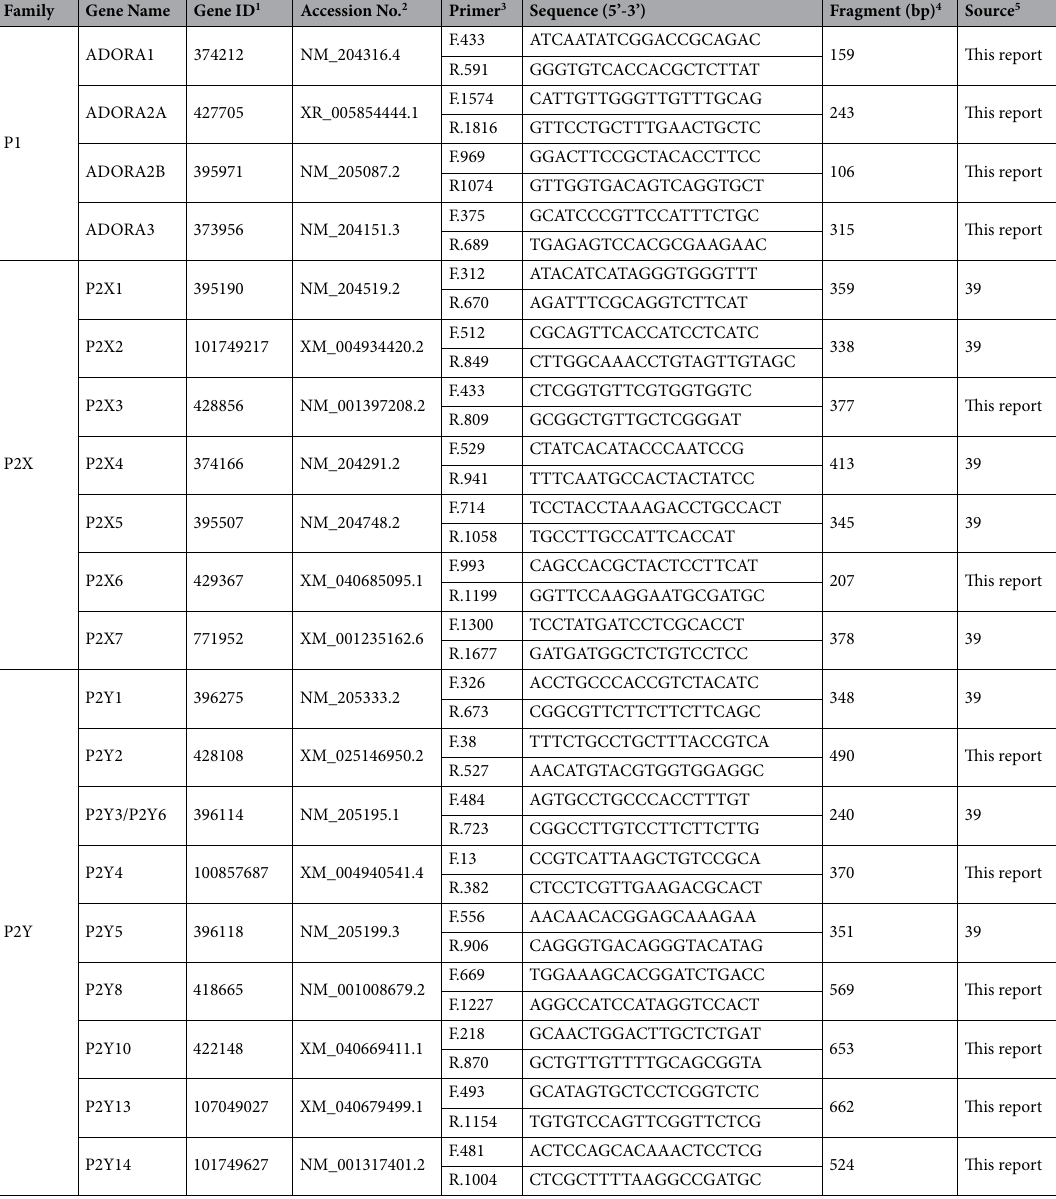
Table 1. Purinergic receptors primer sets used for RT-qPCR assays. 1 National Center for Biotechnology Information (NCBI) Gene ID for Gallus gallus (chicken). 2 NCBI mRNA Accession No. 3 Primer direction (F-forward; R-reverse) and hybridization position in gene. 4 Amplicon size in base pairs. 5 Source of primer